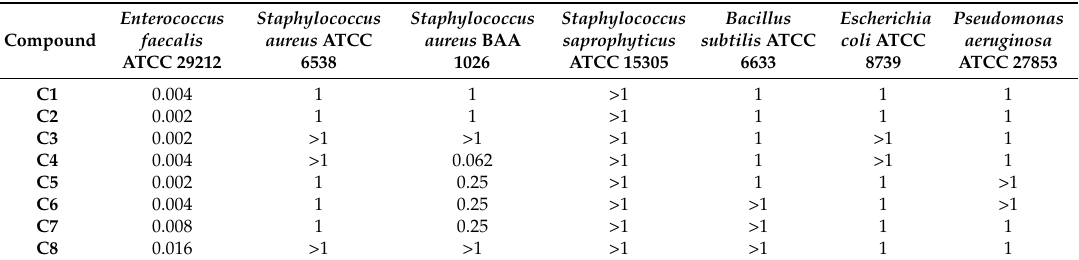
Table 3. The minimal biofilm eradication concentration MBEC (mg mL − 1 ) values of the tested compounds against the tested microbial